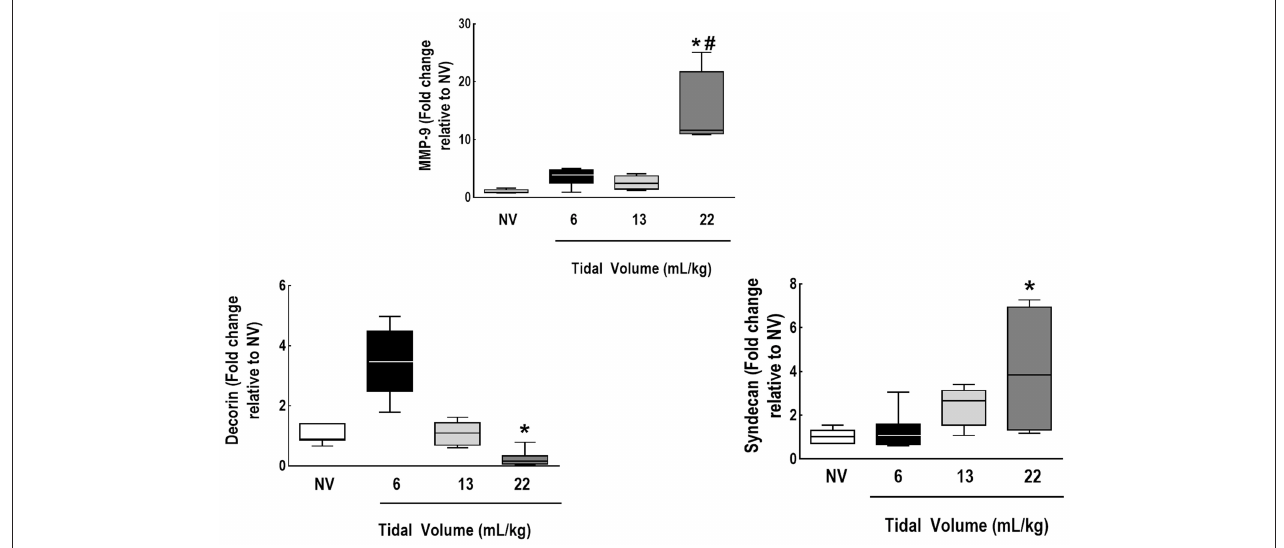
FIGURE 6 | Expression of biomarkers associated with extracellular matrix damage and metalloproteinase. Real-time polymerase chain reaction analysis of markers of extracellular matrix damage (syndecan-1 and decorin) and of metalloproteinase (MMP)-9. Relative gene expression was calculated as the ratio of average gene expression levels to reference gene ( 36B4 ) expression and presented as fold change relative to non-ventilated animals (NV). Values are medians and interquartile ranges of 7 rats in each group. Comparisons among all groups were done by the Kruskal-Wallis test followed by Dunn’s test ( p < 0.05). *vs. V T = 6 mL/kg ( p < 0.05). # vs. V T = 13 mL/kg ( p < 0.05).